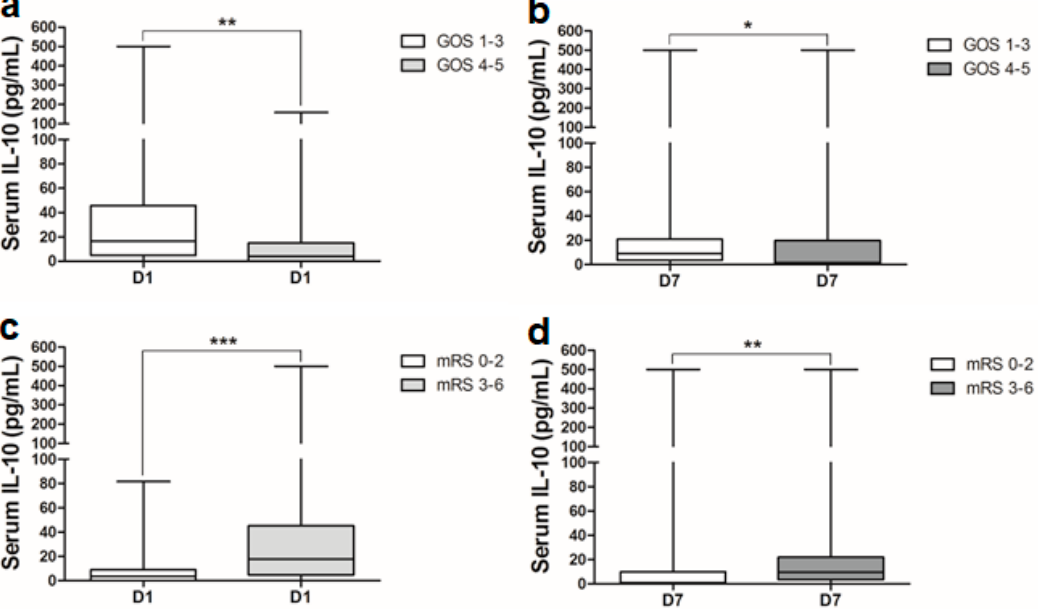
Figure 5. Comparison of serum IL-10 levels between SAH patients with: ( a ) good clinical outcome (GOS 4–5, n = 40) and poor outcome (GOS 1–3, n = 36); ( b ) good clinical outcome (GOS 4–5, n = 40) and poor outcome (GOS 1–3, n = 36); ( c ) good clinical outcome (mRS 0–2, n = 35) and poor outcome (mRS 3–6, n = 41); ( d ) good clinical outcome (mRS 0–2, n = 35) and poor outcome (mRS 3–6, n = 41). Mann–Whitney U test; p < 0.05 is significant (* p < 0.05; ** p < 0.01; *** p < 0.001).